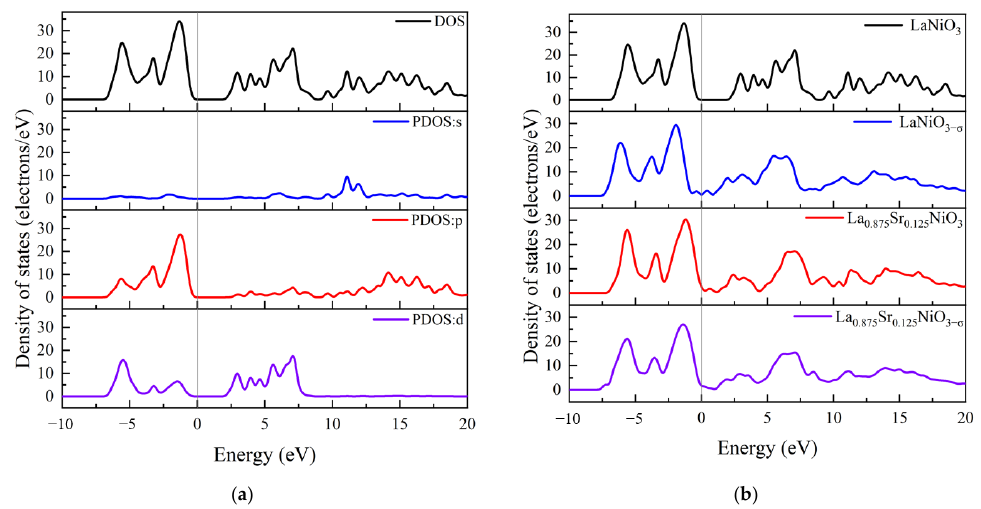
Figure 10. ( a ) The density of state and partial density of state of LaNiO 3 ; ( b ) Density of state of four supercells.